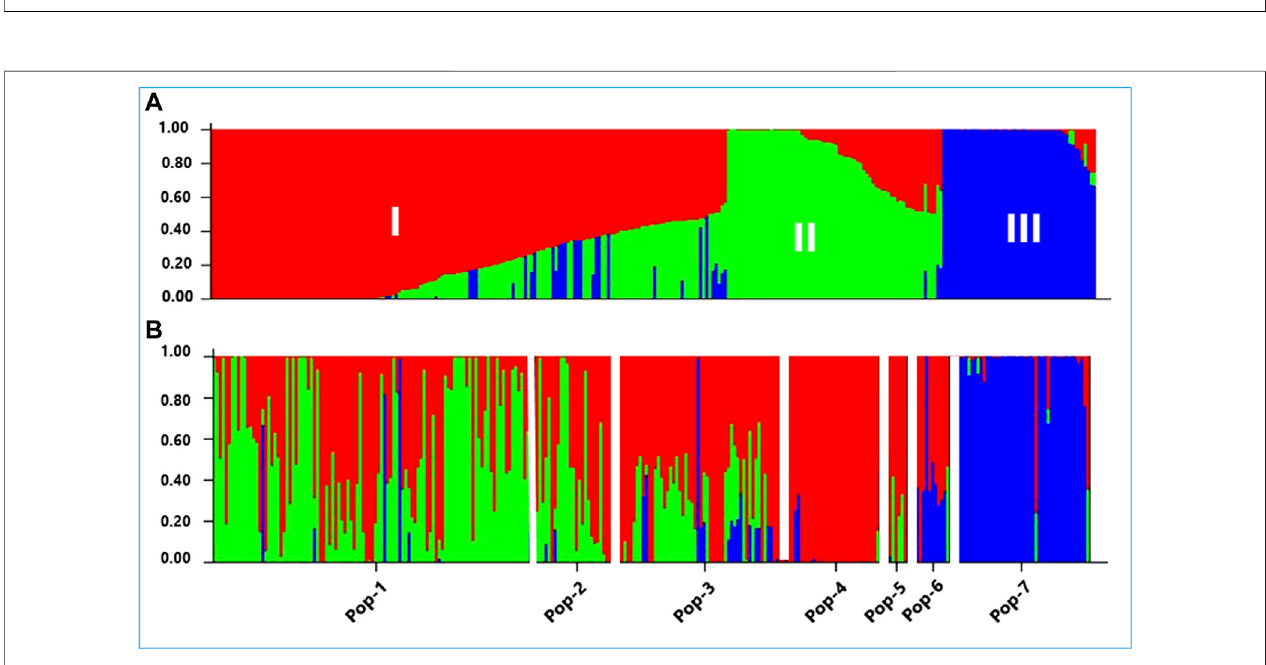
FIGURE 7 | Bi-plot of principal coordinate analysis (PCoA) generated using 5,226 SNP markers depicting the genetic relationship among the 288 fi nger millet accessions. A symbol of the same shape and color represents accessions of the same population.